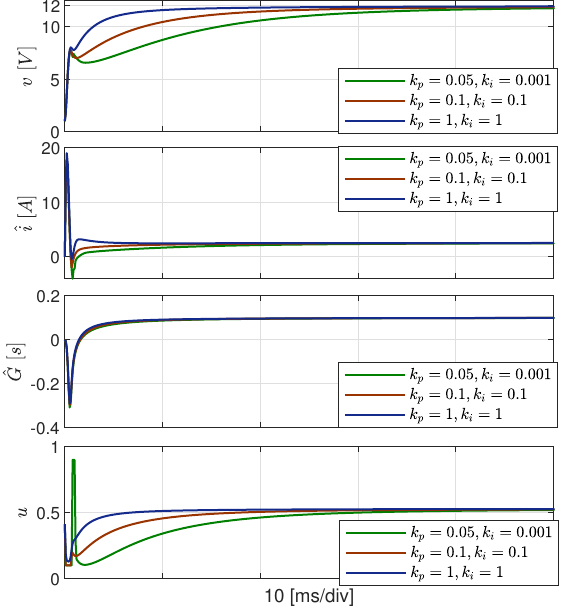
Figure 3. The response curves of boost converter under the proposed controller with different gain.